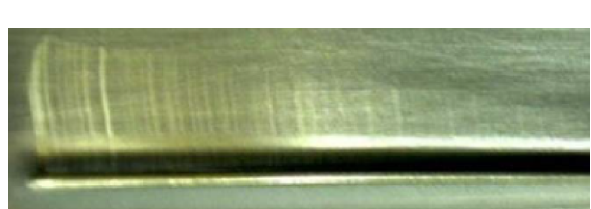
Figure 6. Defect example: scratches Scratches are visible grooves in the surface.